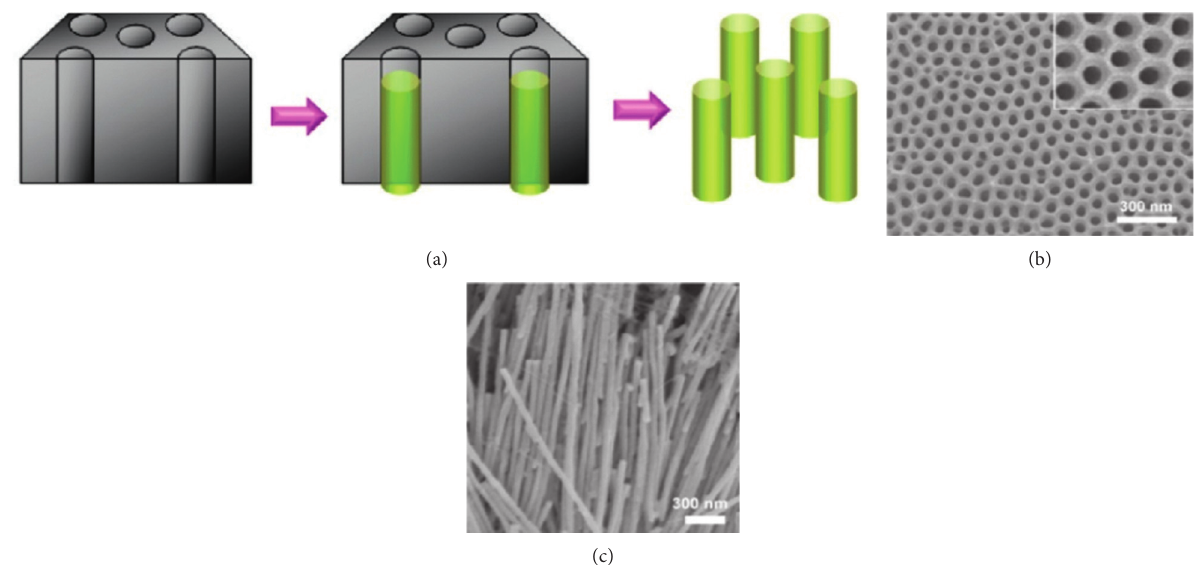
Figure 2: (a) Scheme of hard mold, (b) the scanning electron microscope image of anodic aluminum oxide mold, and (c) the scanning electron microscope image of CoPt 3 nanowires produced by the hard mold method [2].